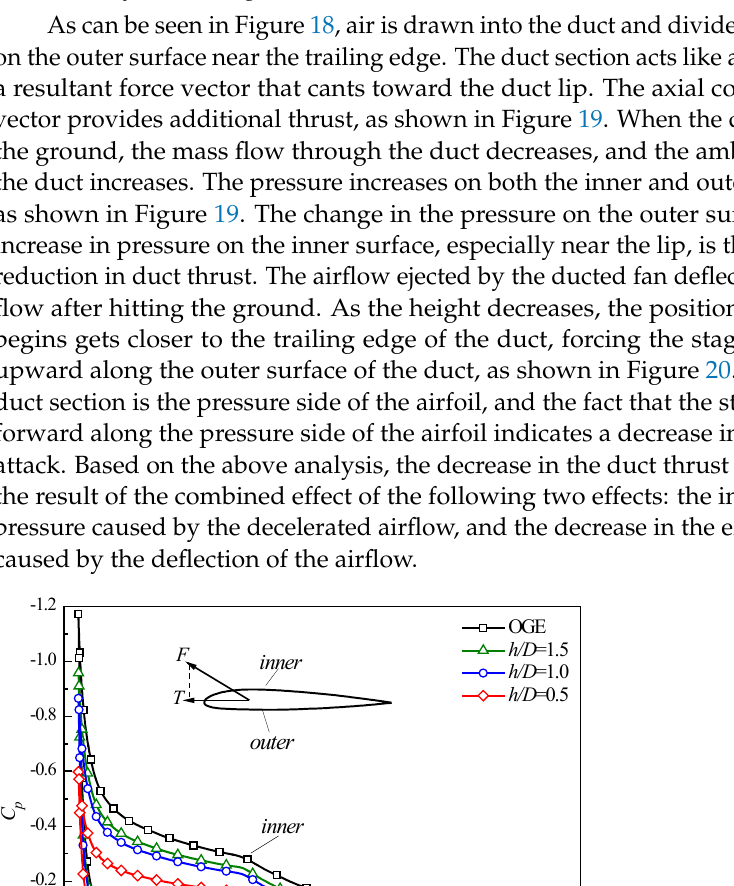
Figure 20. Stagnation streamlines of duct section at Ψ = 22.5°.